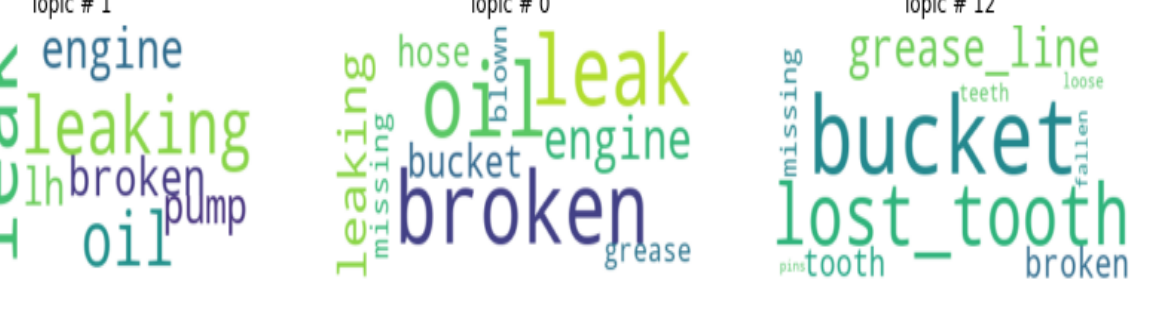
Figure 9. Word Cloud of Topics from HDP.